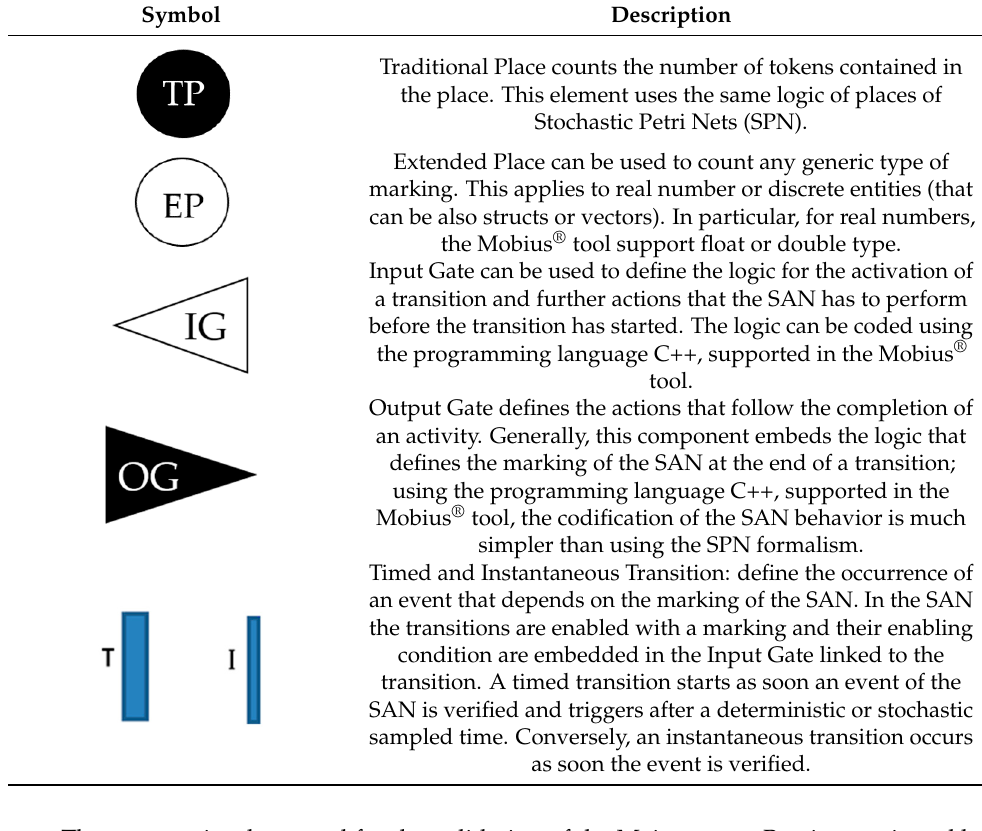
Table 6. Main elements of the Stochastic Activity Network (SAN) formalism.